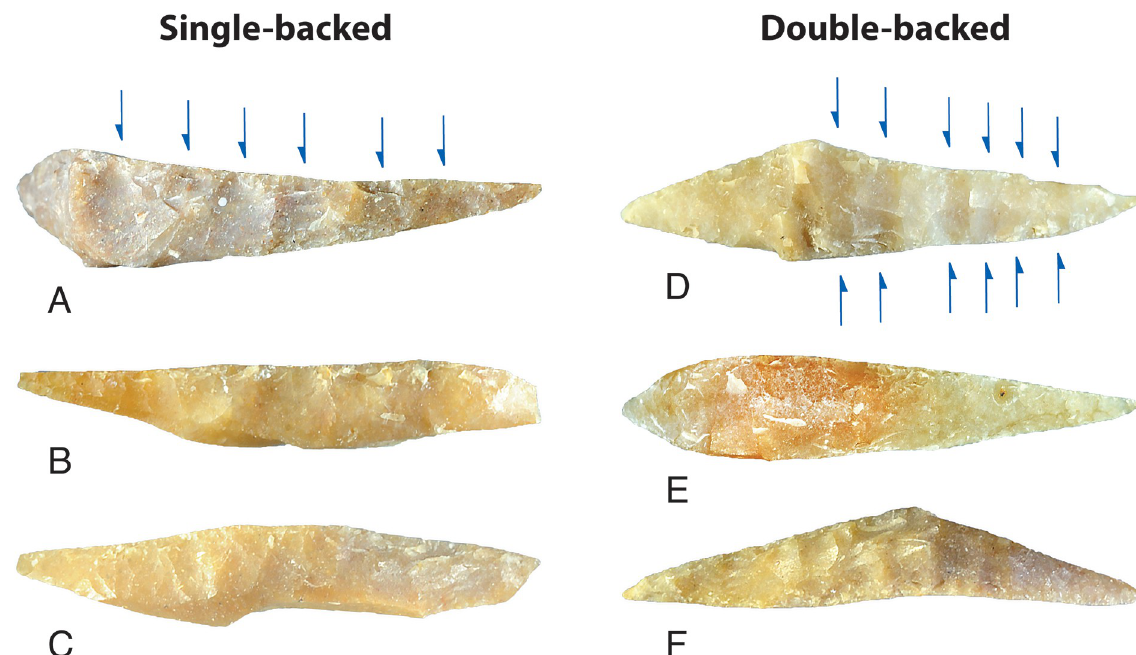
Fig 29. Single- and double-backed microliths, Horizon IV, Saruq al-Hadid. In the top examples, the arrows indicate the directions of the main flake scars. From contexts 2022 (A), 2008 (B), 2321 (C), 2049 (D), 2822 (E), and 1748 (F). Not to scale.